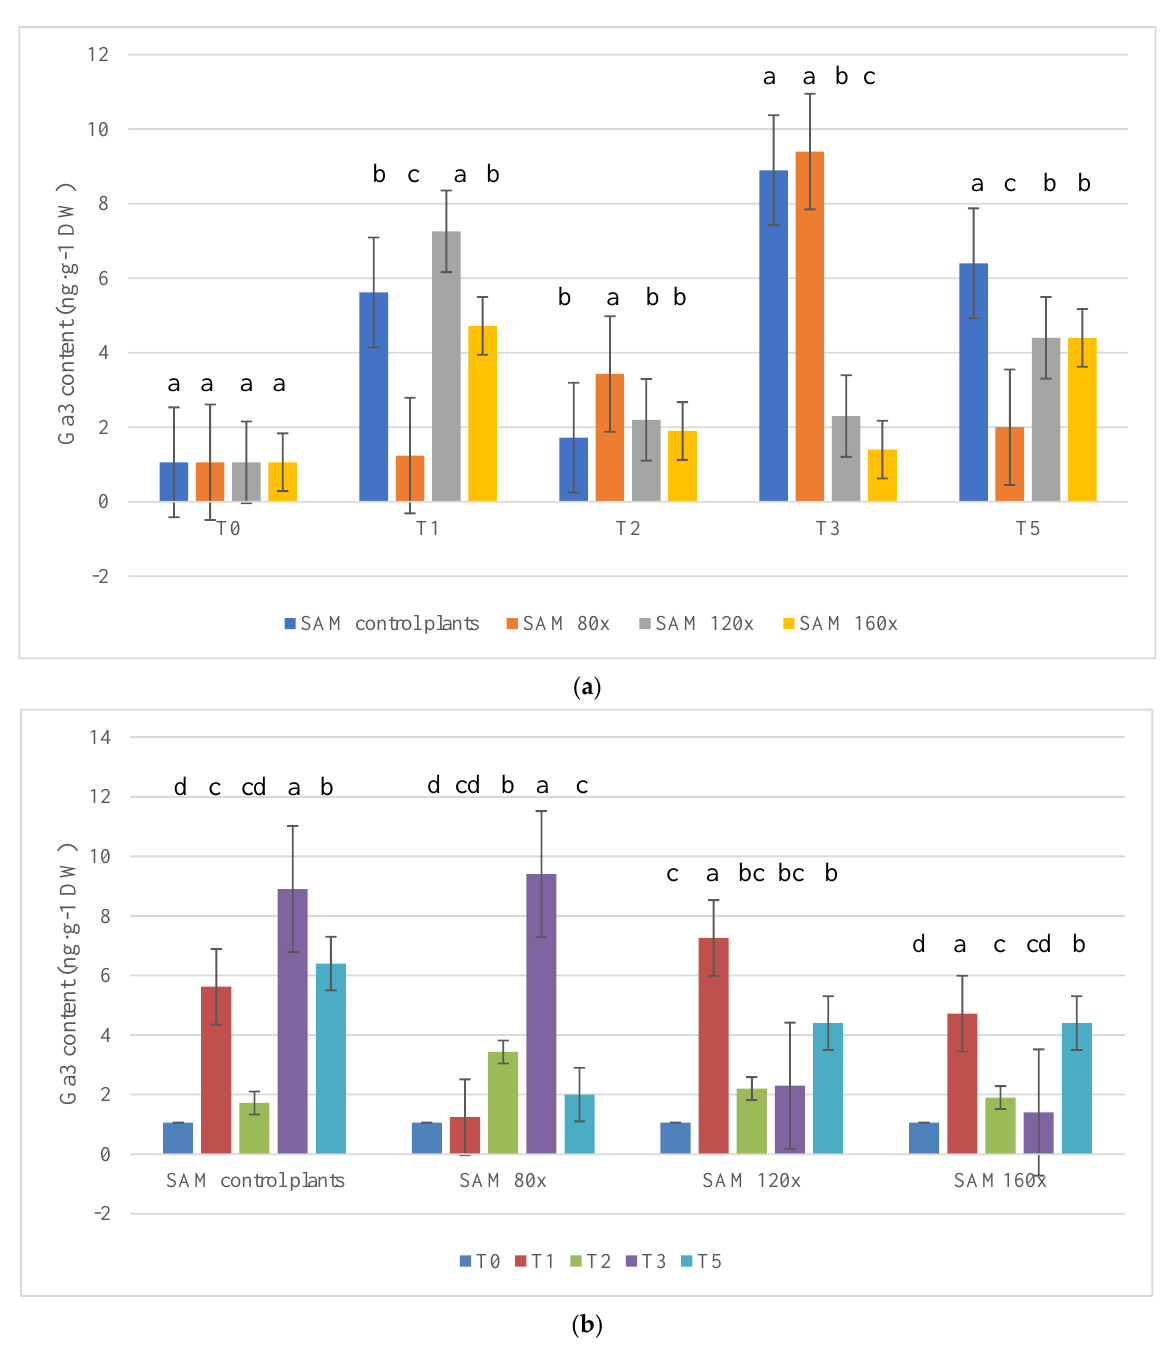
Figure 4. ( a ) Gibberellic acid (GA 3 ) content (ng·g −1 DW) in the apical meristem of stems [SAM], analyzed separately, of petunias subjected to MS depending on stress intensity. The specimen was collected from 15 plants in each block from each treatment in each of the five terms (α = 0.05). ( b ) Gibberellic acid (GA 3 ) content (ng·g −1 DW) in the apical meristem of stems [SAM], analyzed separately, of petunias subjected to MS depending on stress duration. The specimen was collected from 15 plants in each block from each treatment in each of the five terms (α − 0.05). The lowercase letters present statistical differences (α − 0.05) between the treatments.